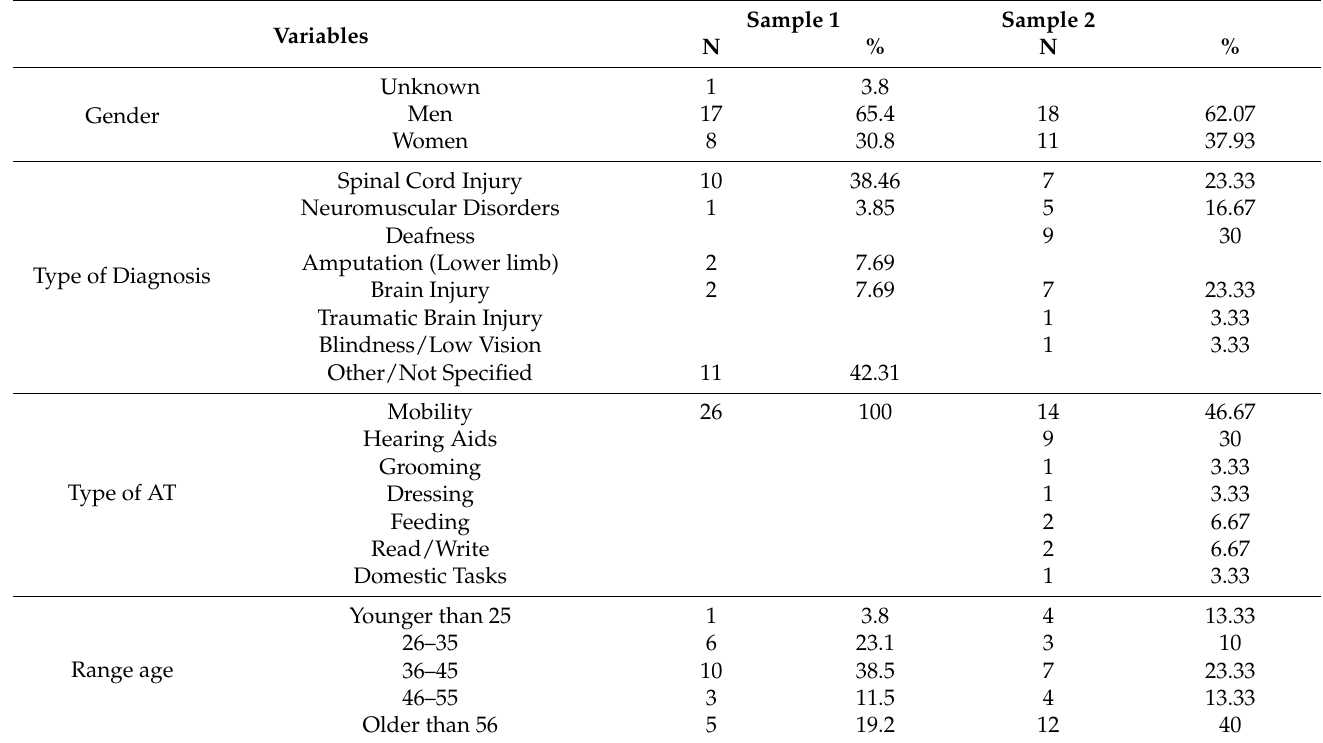
Table 1. Descriptive results from sample 1 and sample 2.